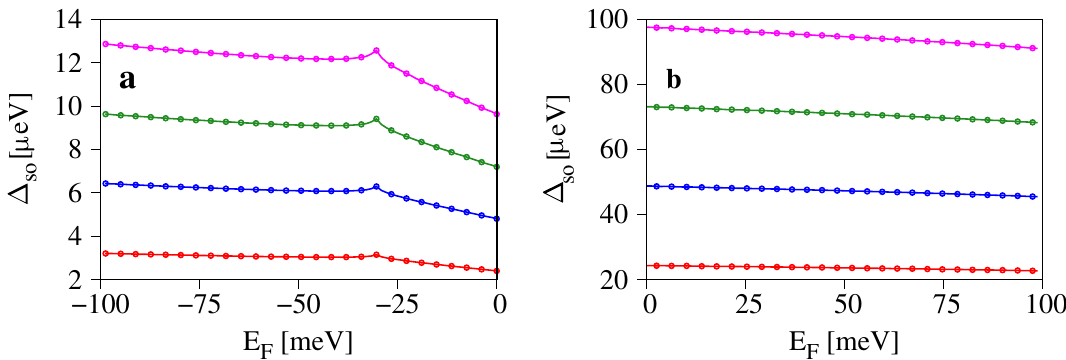
Figure 3. Fermi contour averaged spin splitting versus Fermi level for several values of the external electric field E, and for: ( a ) the top most valence band; ( b ) the bottom most conduction band. The Fermi level is measured with respect to the valence (conduction) band maximum